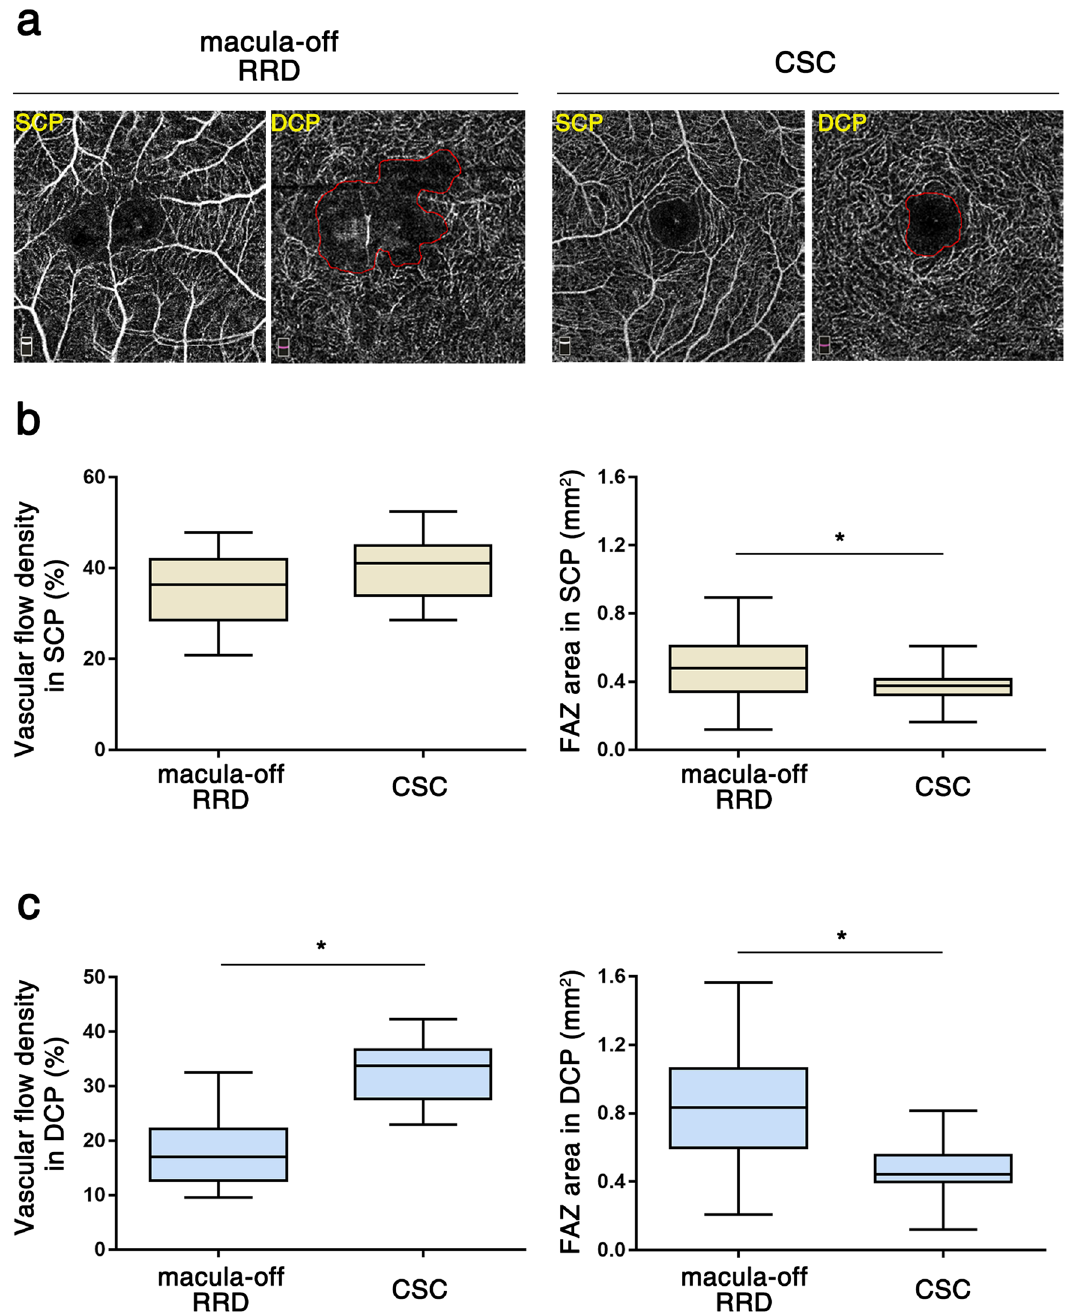
Figure 1. Macular perfusion state after reattachment in rhegmatogenous retinal detachment (RRD) and central serous chorioretinopathy (CSC). ( a ) Optical coherence tomography angiography results in both RRD and CSC eyes. Multiple dropouts in the macular capillary vessels in the deep capillary plexus (DCP) and an enlarged foveal avascular zone (FAZ) in both the superficial and deep capillary plexuses in RRD. In contrast, CSC shows well-preserved vascular flow density and small FAZ areas in both capillary plexuses. ( b ) In the superficial capillary plexus (SCP), vascular flow density was not different between RRD and CSC ( p = 0.074). The FAZ area was significantly larger in RRD than in CSC ( p < 0.003). ( c ) In the deep capillary plexus (DCP), vascular flow density was lower in RRD than in CSC ( p < 0.001). The FAZ area was also larger in RRD than in CSC ( p <